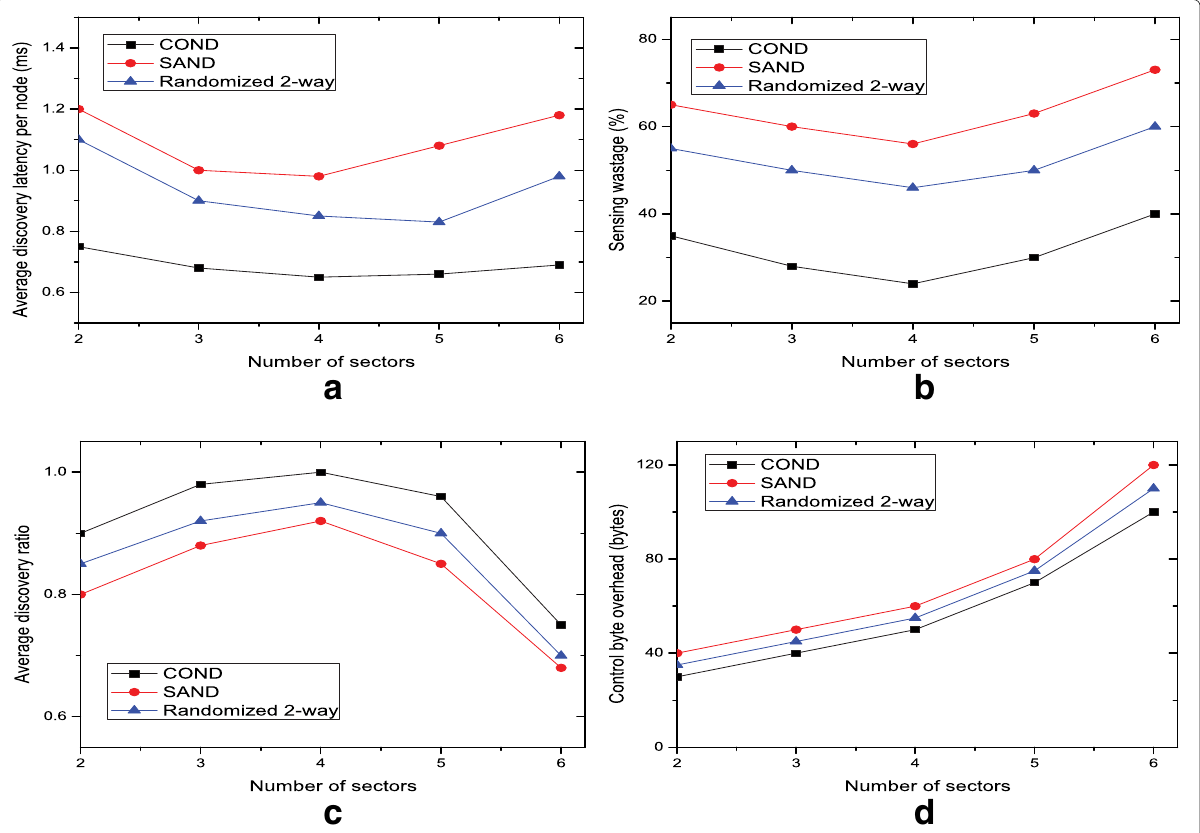
Fig. 7 Impacts of number of sectors on performances of the studied neighbor discovery algorithms. a Average discovery latency. b Sensing wastage of discovery slots. c Average discovery ration. d Control byte